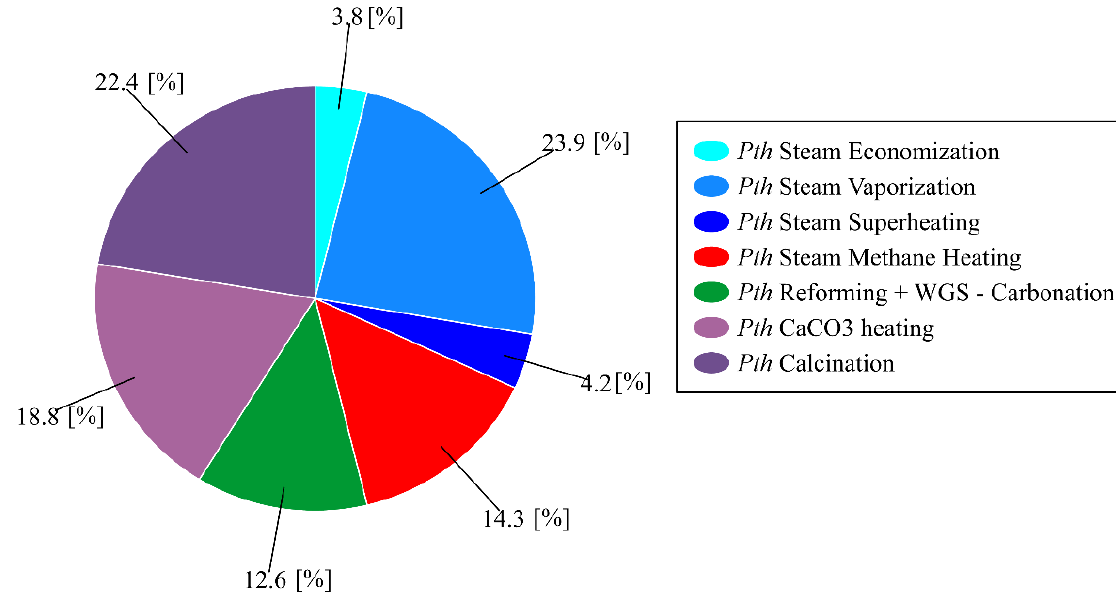
Figure 4. Contributions (%) of the whole thermal power required by SESMR. The 3.8%, 23.9%, and 4.2% shares of the total required power were related to the water Pth , 1 represented a significant part (31.9%) of the whole Pth ,req . Concerning the